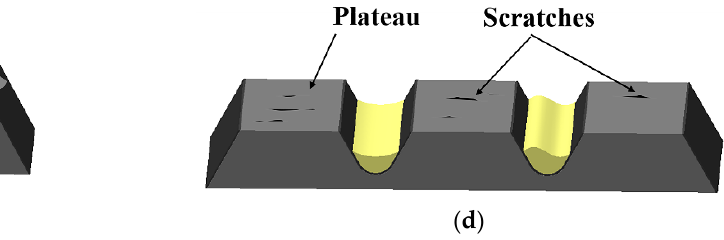
Figure 15. The simplified wear process of piston skirt sliding against cylinder liner: ( a ) running-in stage, ( b – d ) wear process.